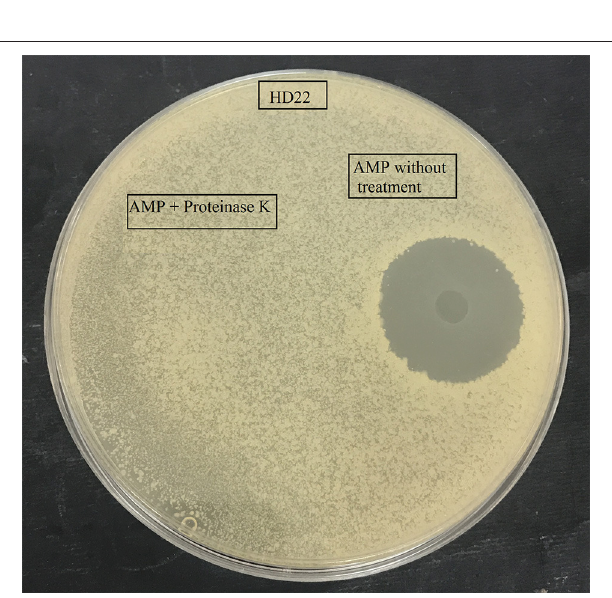
FIGURE 1 | Effect of proteinase K treatment on antimicrobial activity of the purified AMP against B. thuringiensis